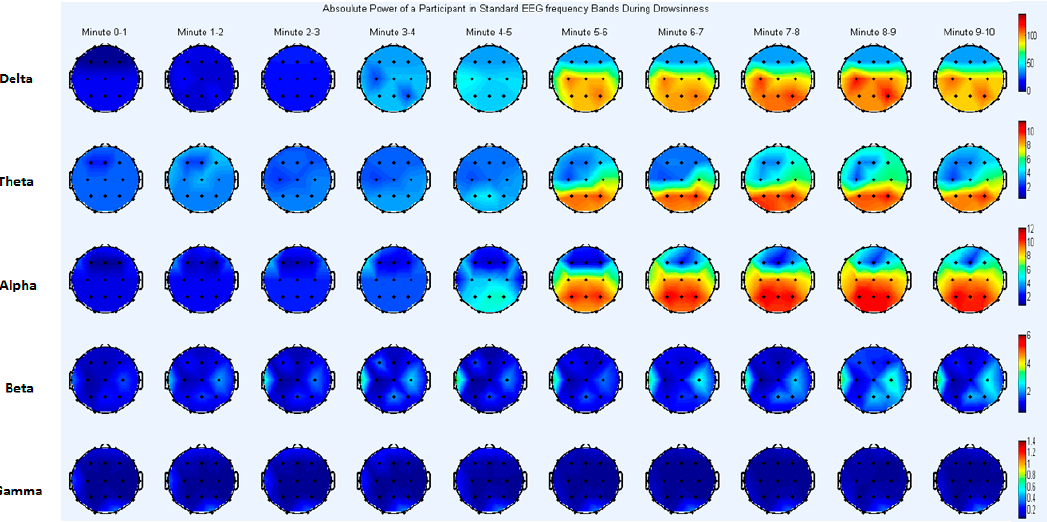
Figure 4. Brain topography of absolute power for standard EEG frequency bands obtained from the EEG data of one subject.